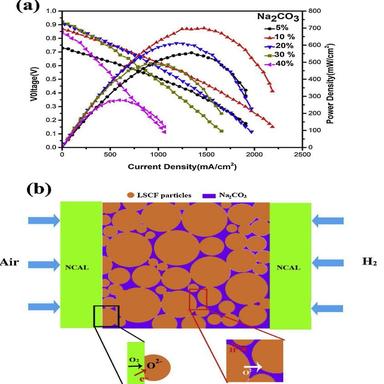
(a) I–V and I–P characteristics of the fuel cell with different carbonate content at 550 °C. (b) the device configuration and charge transport illumination for the fuel cell based on LSCF/Na2CO3 composite.